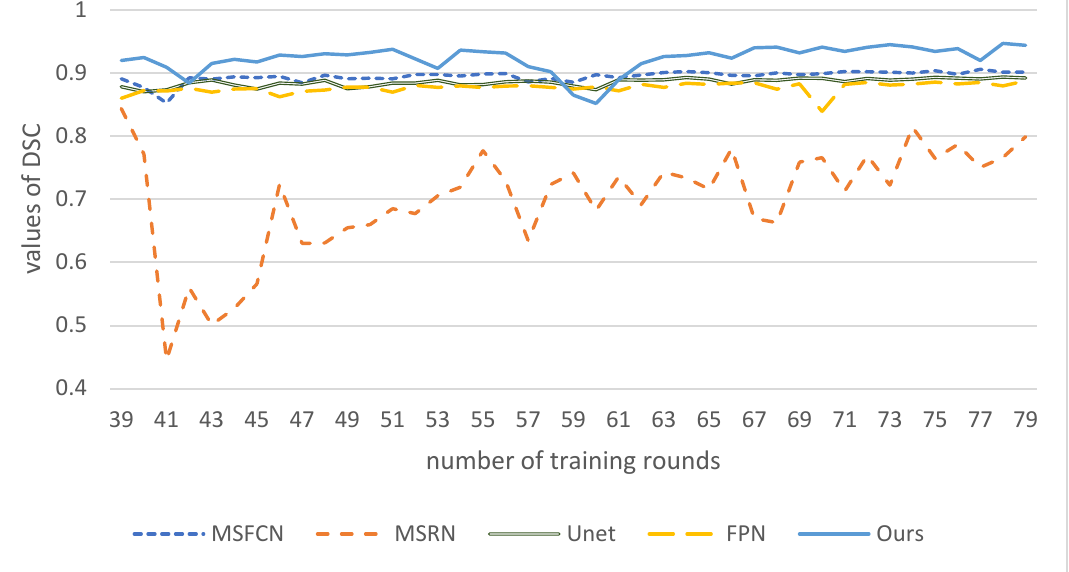
Figure 16. DSC values of different models under certain epochs.